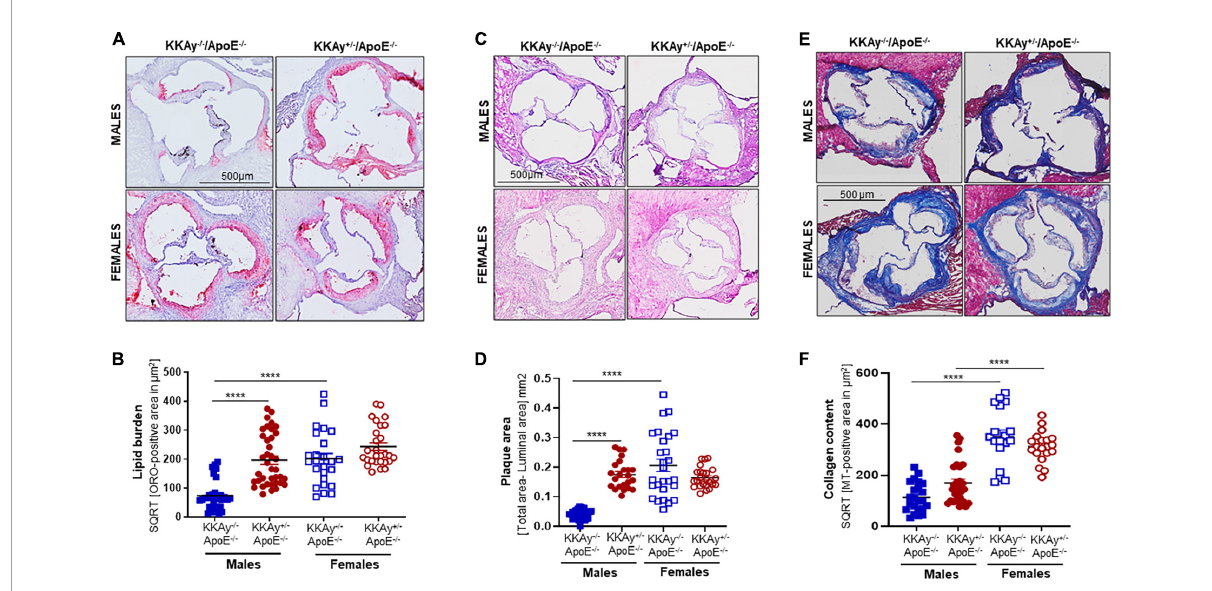
FIGURE3 Sex-specific differences in lesion lipid burden, plaque area and collagen content in MetS KKAy + / − ApoE − / − and non-MetS KKAy − / − ApoE − / − mice. Serial sections of equivalent regions of the aortic root were stained with 0.5% Oil red O (ORO) followed by hematoxylin counterstaining. ORO-positive area (measured in µ m 2 ) was quantified using Image J. Shown are (A) representative ORO-stained aortic root sections, (B) summary data for ORO-positive area. n = 7–9 mice per genotype per sex (2–5 sections per mouse). Aortic root serial sections were stained with hematoxylin and eosin (H&E). Aortic root luminal area and total aortic root area (i.e., area enclosed by the internal elastic lamina in mm 2 ) were measured using Image J; difference between total root area and luminal area denotes plaque area. Shown are (C) representative images for H&E-staining, (D) summary data for plaque area. n = 5–8 mice per genotype per sex (4–5 sections per mouse). Identical aortic root sections were stained with Masson’s Trichrome (MT) followed by hematoxylin counterstaining. MT-positive area (measured in µ m 2 ) depicting collagen content was quantified in Image J. Shown are (E) representative images for MT staining and (F) summary data for collagen content, n > 12 individual sections for each genotype per sex. All images were captured at 10 × magnification. **** p <